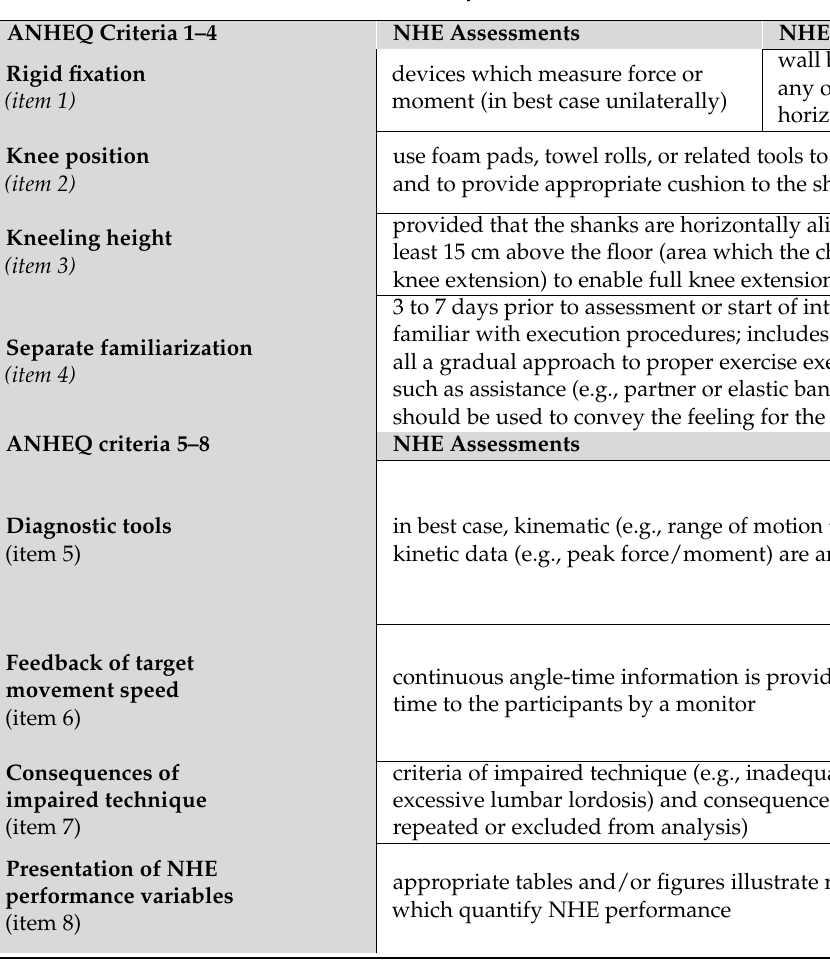
Table 1. Practical recommendations for Nordic Hamstring Exercise (NHE) assessments and interventions following the criteria for Assessing Nordic Hamstring Exercise Quality (ANHEQ)